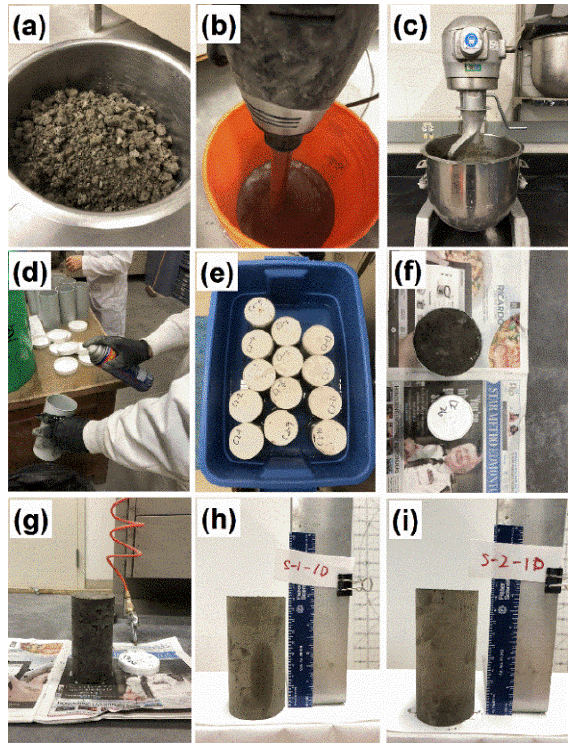
Figure 9. Specimen preparation: ( a ) lumped stiff clay in a container, ( b ) making cement slurry, ( c ) mixing slurry with soils, ( d ) lubricating the plastic molds, ( e ) curing in a rubber container filled with water, ( f , g ) cylinder specimens with a diameter of 75 mm, and ( h , i ) cylinder specimens with a diameter of 50 mm.